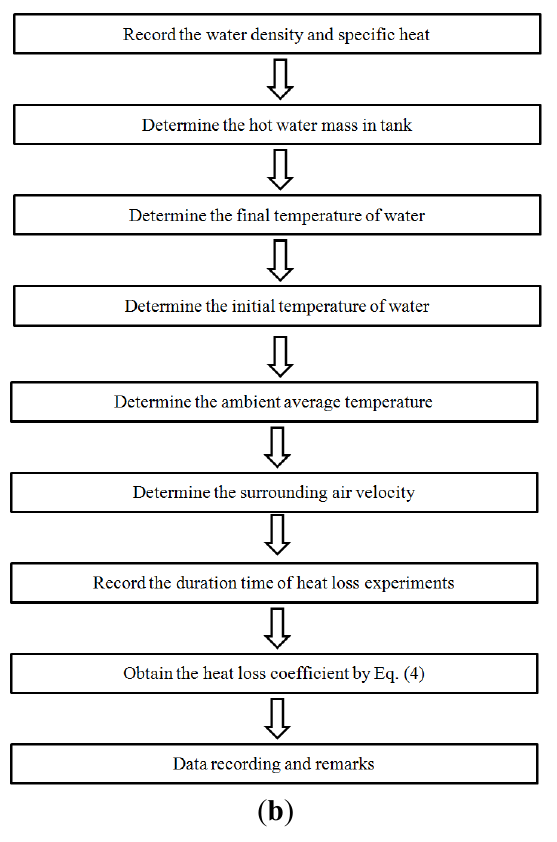
Figure 11. Flow chart of the conventional method for determining ( a ) heat collection and ( b ) heat loss coefficient.